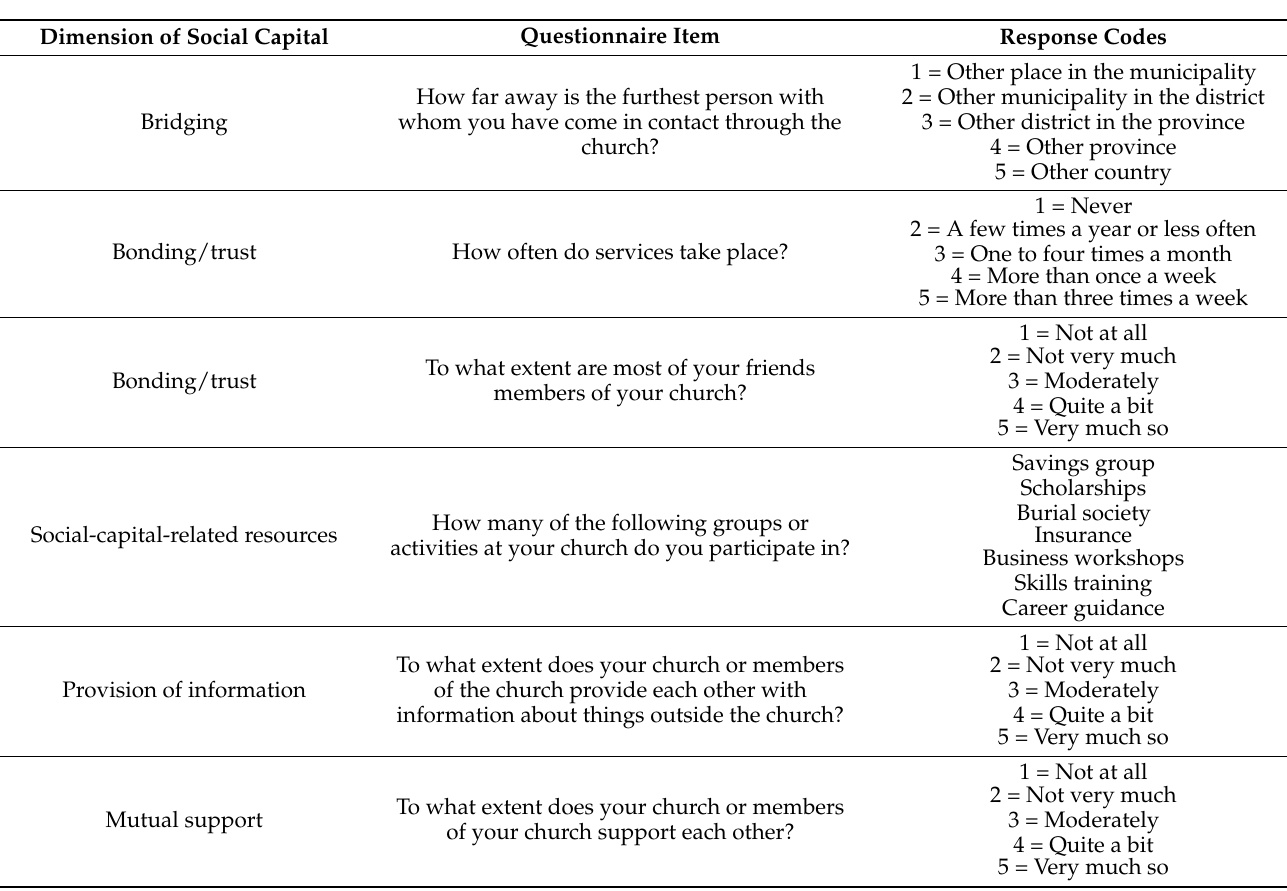
Table 4. Inventory of the religious social capital